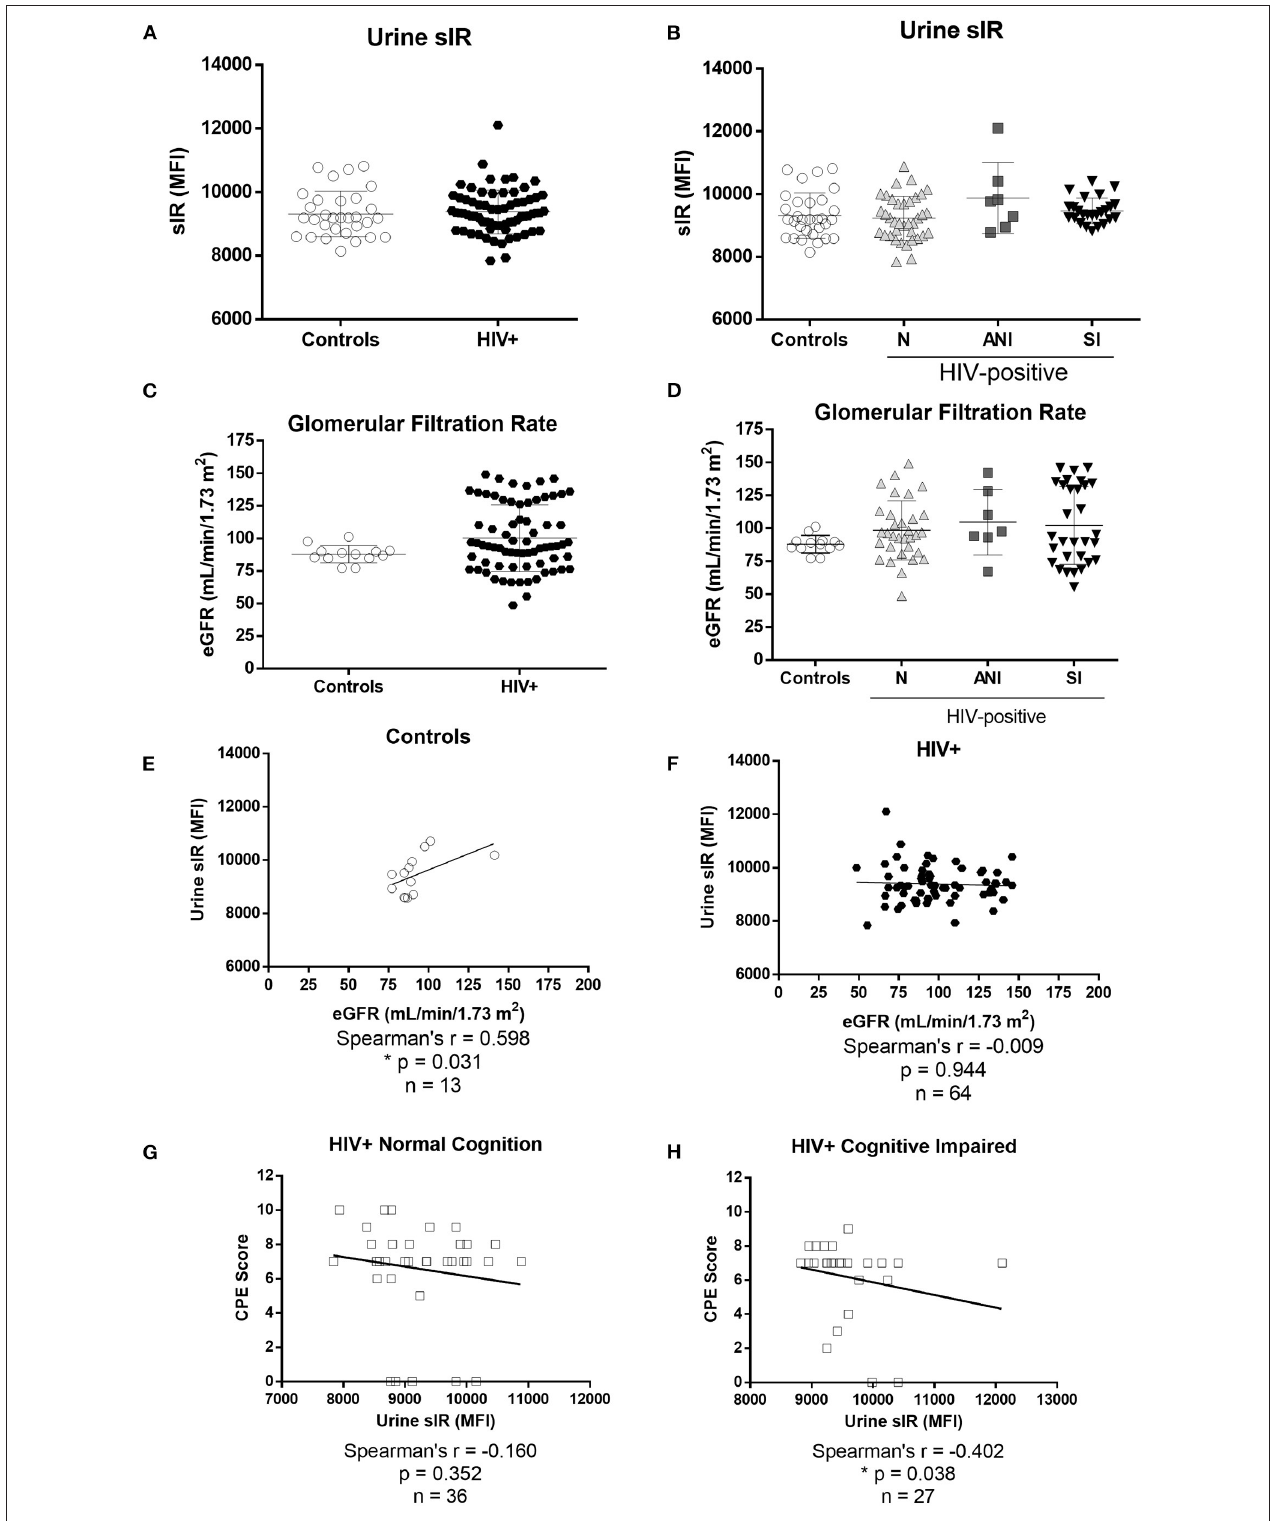
FIGURE 5 | Levels of soluble insulin receptor in urine and estimated glomerular filtration rate of HIV-negative control and HIV-infected women. sIR was measured in the urine of HIV-negative (controls n = 31) and HIV-infected ( n = 76) by flow cytometry (A) . HIV-infected women were stratified by HAND status as normal cognition (N), asymptomatic cognitive-impaired (ANI), and symptomatic impaired (SI; MND and HAD) (B) . eGFR (ml/min/1.73 m 2 ) was measured in HIV-negative controls